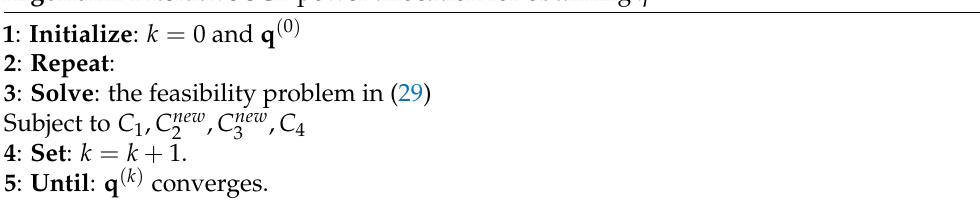
Algorithm 4 Iterative SCP power allocation for obtaining q